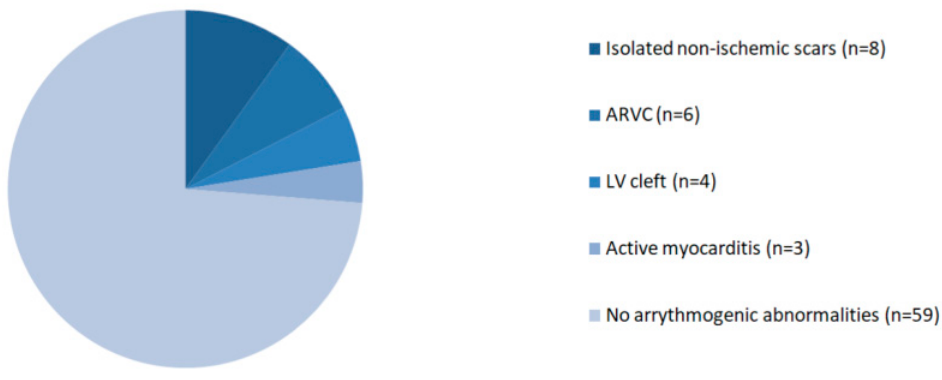
Figure 2. Abnormal CMR findings. ARVC—arrhythmogenic right ventricular cardiomyopathy. The examples of detected findings are shown on Figure 2.